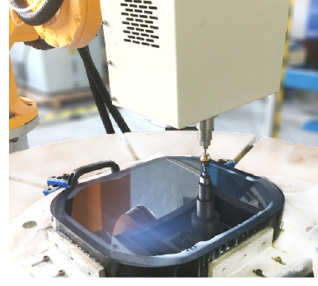
Fig. 3. Primary mirror substrate polishing by robot.